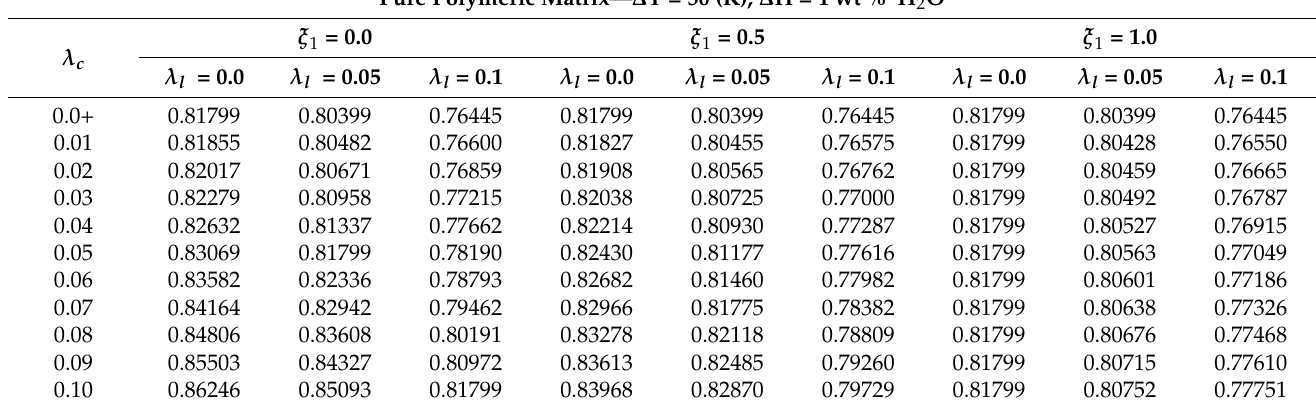
Table 4. Normalized fundamental flexural frequency of simply supported nano-beam of pure polymeric matrix for ∆ T = 50 ( K ) and ∆ H = 1 wt % H 2